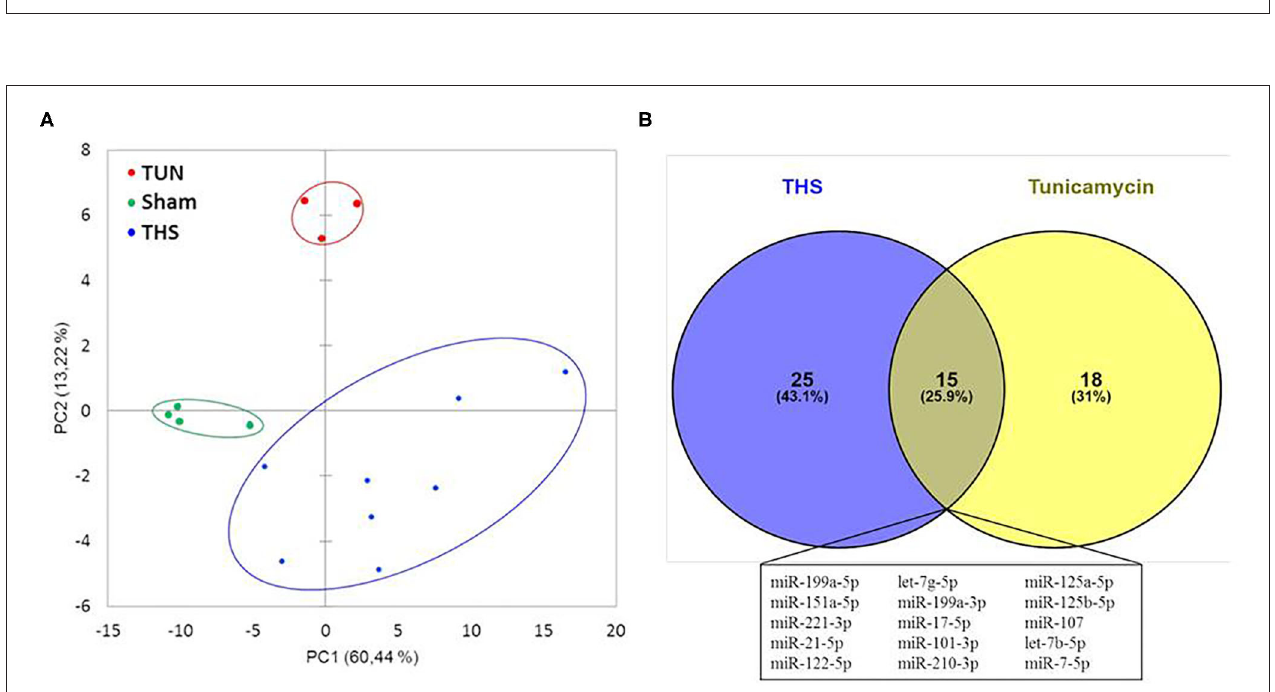
FIGURE 4 | (A) Principal component analysis of miRNAs related to organ injury and ER stress; THS group ( n = 8); sham group ( n = 4); tunicamycin (TUN) group ( n = 3). (B) Venn diagram with miRNAs significantly regulated in THS and upon tunicamycin treatment ( p < 0.01). Blue: 25 miRNAs involved exclusively in THS. Yellow: 18 miRNAs exclusively induced by tunicamycin. Central area: 15 common miRNAs expressed by THS and tunicamycin.